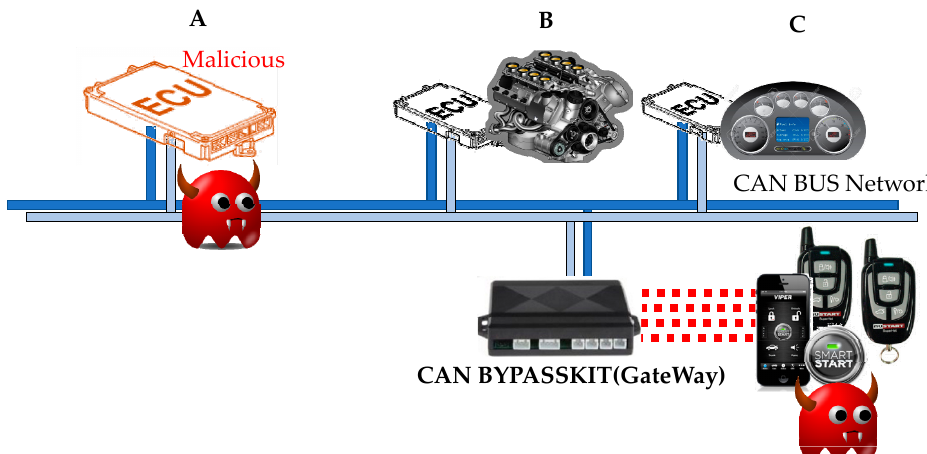
Figure 2. An example of CAN